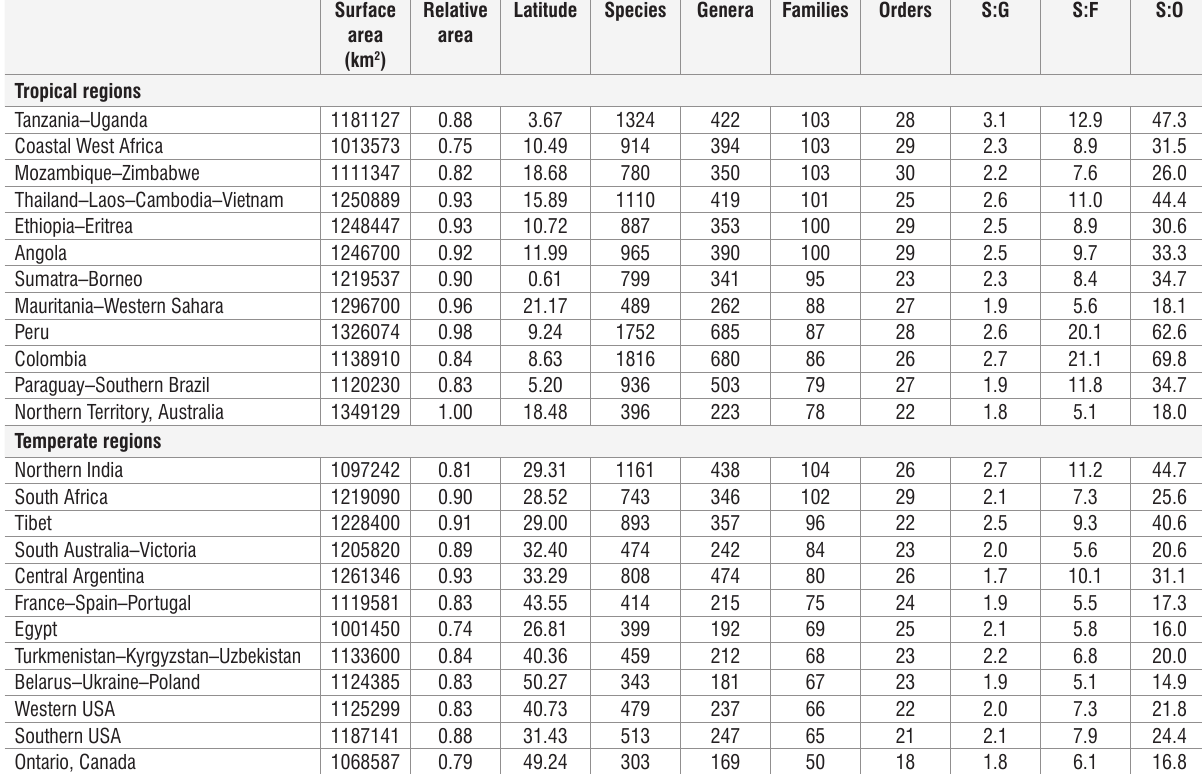
Data for each region studied, in descending order of the number of families in each region